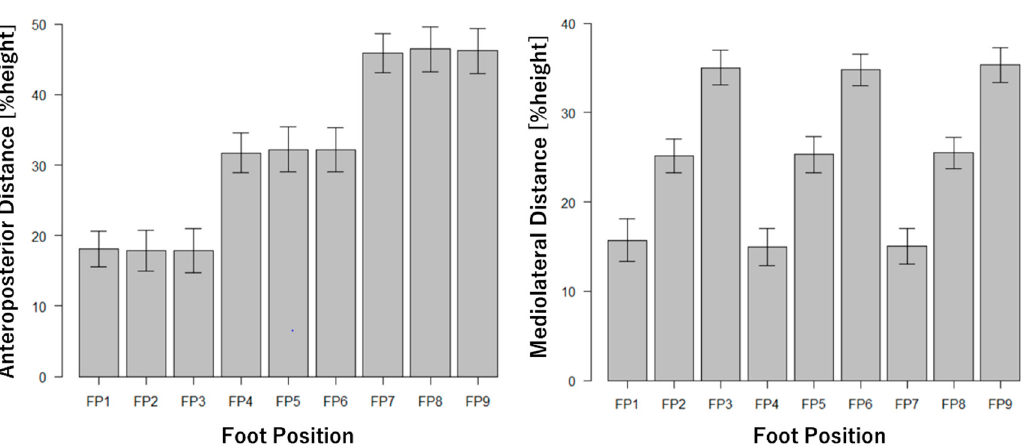
Figure 3. Foot distances of the nine foot positions obtained from the optical motion capture system. %height is feet distance normalized to the body height of each participant. Values are mean ± standard deviations. FP: foot position.